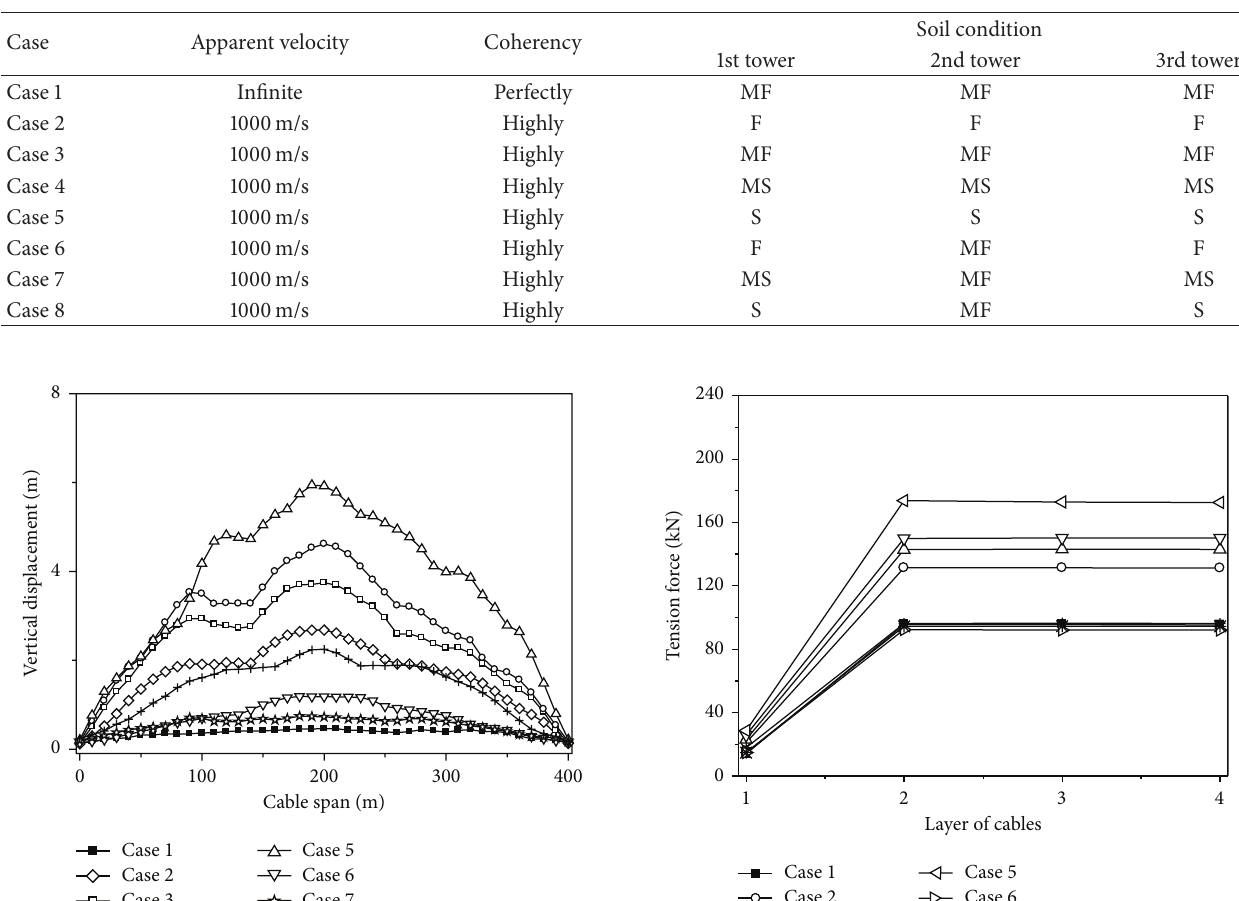
Table 4: Analysis cases considering the effect of local site.